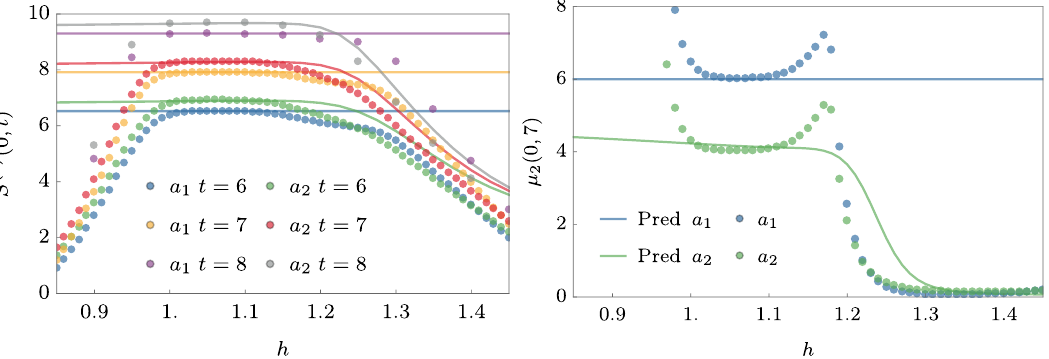
Figure 6: Prediction and numerical data for self-dual kicked Ising model. The points correspond to exact results, and the lines are the predictions using the conjecture (83). In the left panel we show the Rényi n = 2 entropy at times 6,7,8 versus the magnetic field parameter h . The deviations from the prediction observed away from the central region are due to the vicinity of solvable points h = k the model is a Clifford circuit. There the prediction fails, because the transfer matrix has additional eigenvectors of eigenvalue 1. But as time increases, the region where the prediction holds grows. In the right panel we show the more sensitive constant offset factor µ versus the parameter h at t = 7. The operators a 2 as those used in Fig. 4 and they are initialised in y =